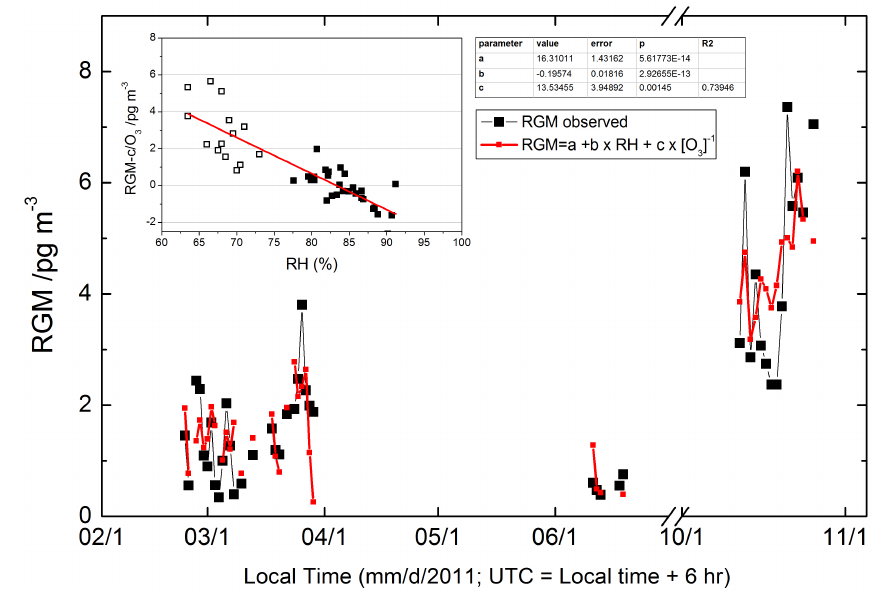
Fig. 8. Multilinear regression of reactive gaseous mercury (RGM) vs. relative humidity (RH) and [O 3 ] − 1 . The daily averaged observed data and the modelled data are shown in black and red respectively as a function of time. The inset shows the residual dependence of RGM on RH after removing the optimised [O 3 ] − 1 contribution to RGM (full squares: March–June, open squares: October).